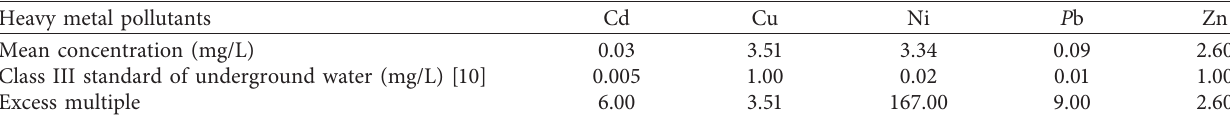
Figure 3: Sample collection in Fuyong sludge landfill. Table 1: Measured concentrations of heavy metal pollutants in the landfill.